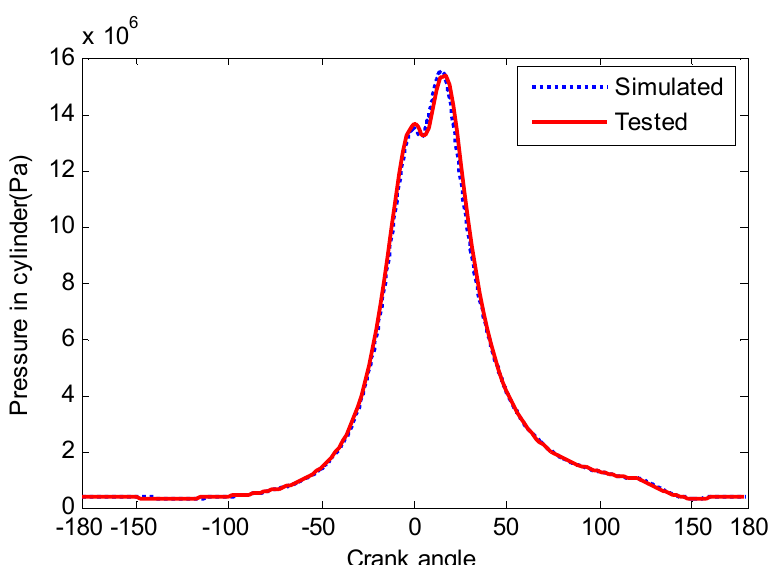
Figure 12. Heat release rate of case 1.